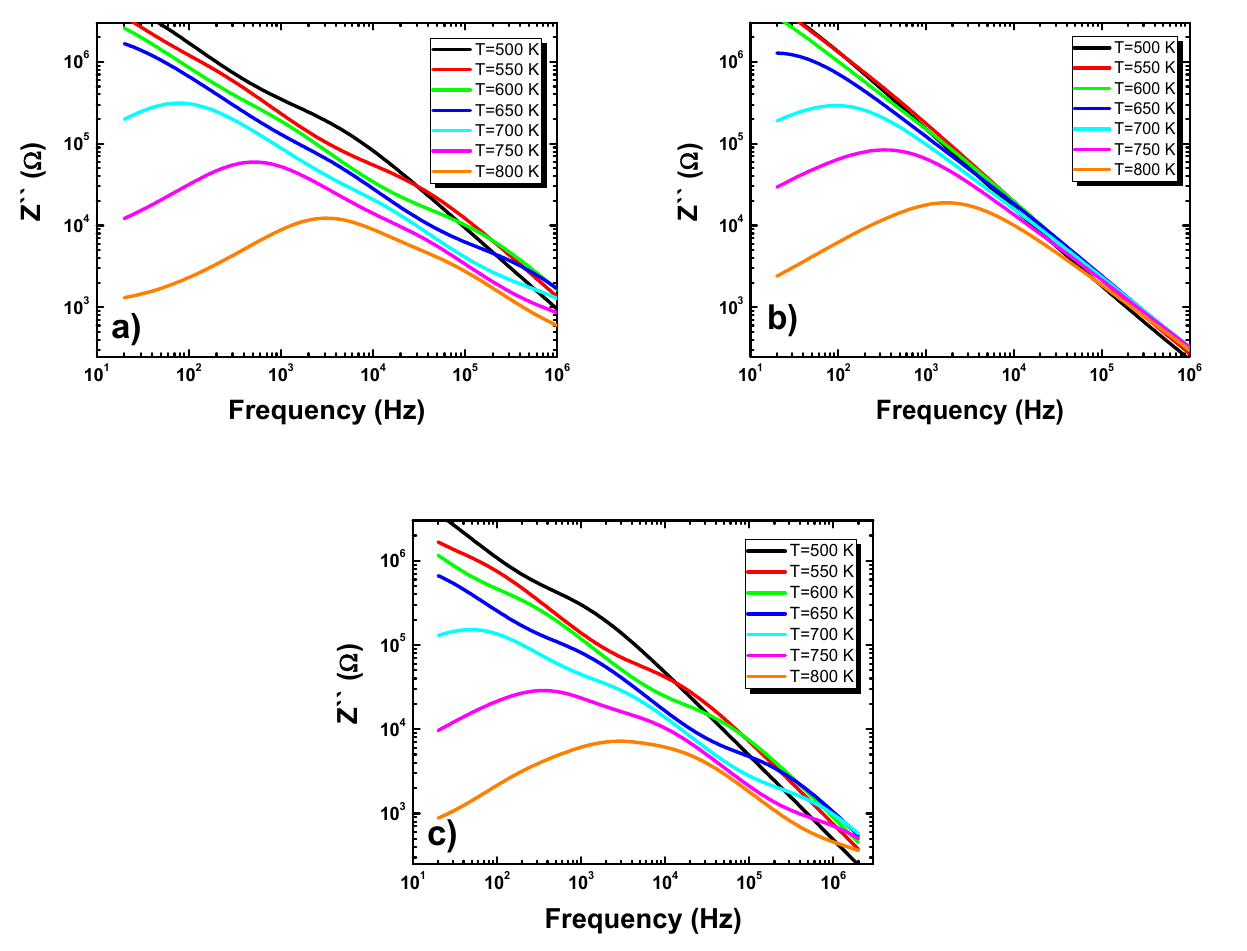
Figure 8. Frequency dependence of the imaginary part of impedance measured at different temperatures for ( a ) europium-modified BLT4 ceramics, ( b ) hafnium-modified BLT4 ceramics, and ( c ) simultaneously hafnium- and europium-modified BLT4 ceramics.